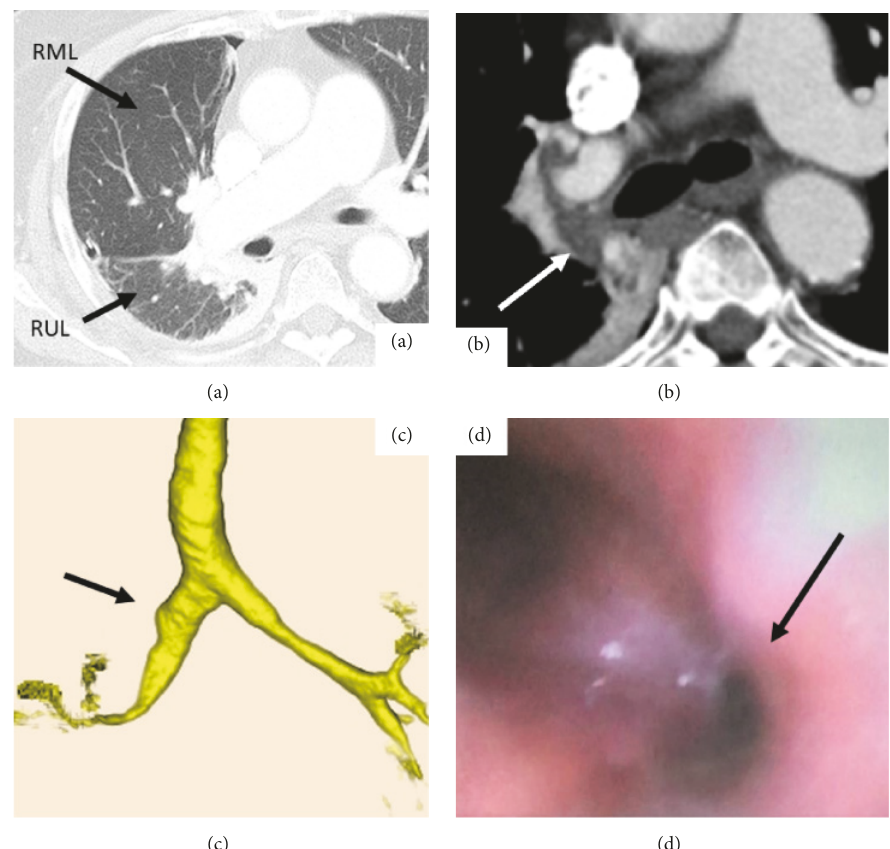
Figure 2: (a) An emergency chest computed tomography (CT) showed the middle lung lobe had been pushed upward and forward, and the right upper lung lobe had twisted dorsally. (b) The right upper bronchus with hilar peribronchovascularsoft tissue edema (arrow). (c) Three- dimensional CT scan of bronchial stenosis (arrow). (d) Emergency bronchoscopy showing severe right upper bronchial stenosis (arrow). RUL: right lower lobe; RML: right middle